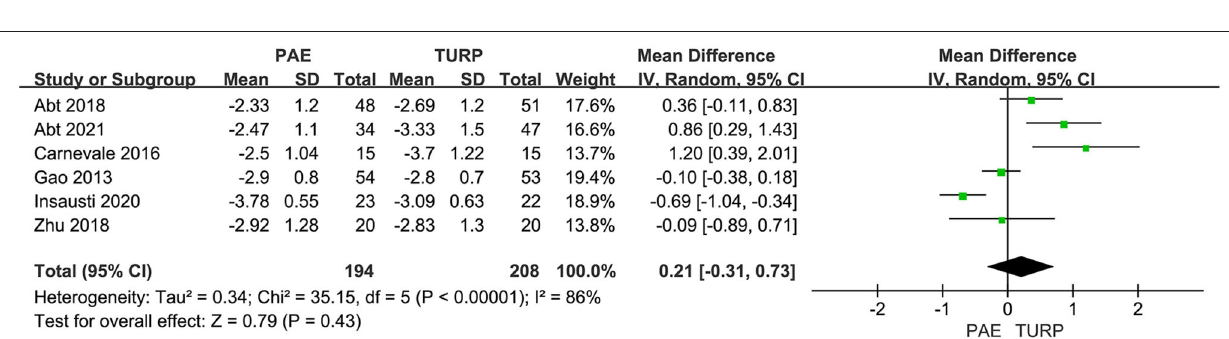
FIGURE 3 | Forest plot for QoL. QOL, quality of life.